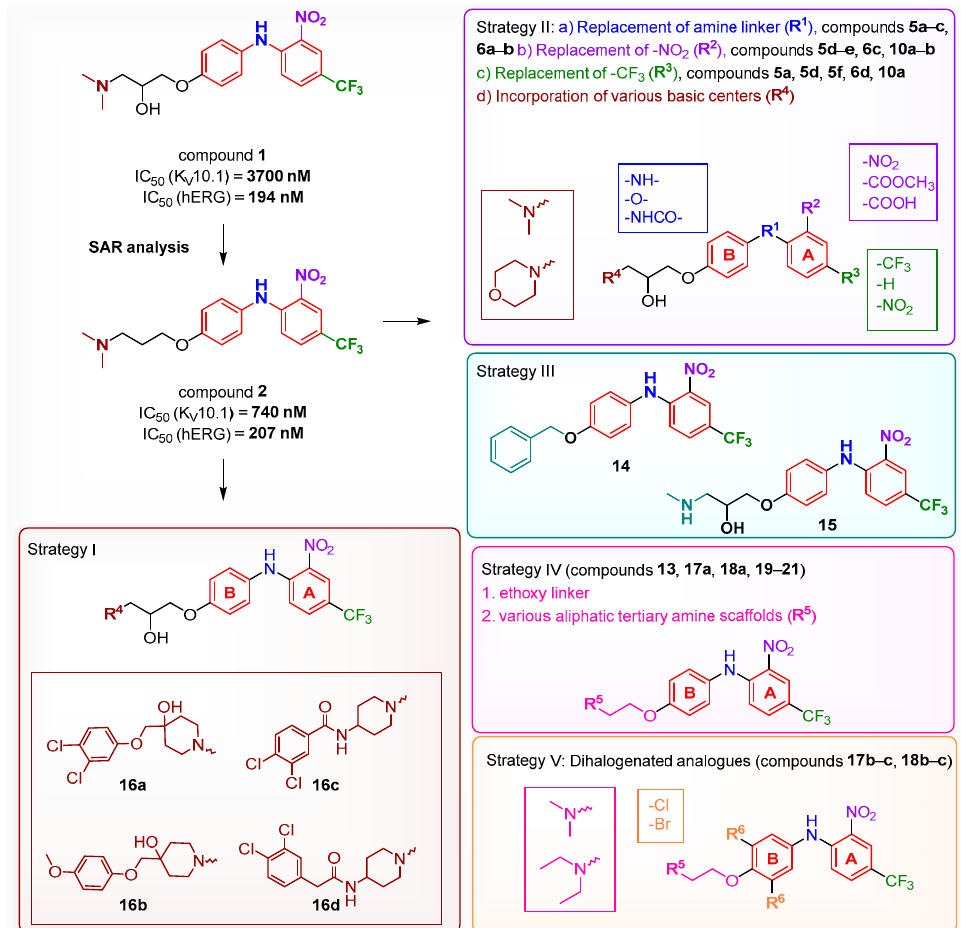
Figure 2. Design of the hit compound ZVS-08 ( 1 ) analogues (Strategies I–V).